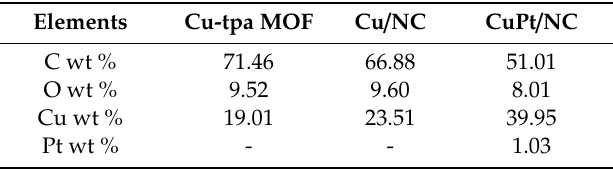
Figure 4. Transmission electron micrographs for CuPt/NC ( a ) 2 0 nm and ( b ) 10 nm . The crystalline structure of Cu-tpa MOF and CuPt/NC (pyrolyzed) was determined with powder XRD as shown in (Figure 5). XRD pattern of Cu-tpa MOF has been transformed after pyrolysis because of the removal of unstable organic linker groups and the formation of nano-porous carbon. Cu and Pt peaks are dominant peaks in the CuPt/NC. XRD graph of CuPt/NC shows sharp peak of Cu (111) at 42.7°, Cu (200) at 50.7°, CuO (−202) at 49.5°, CuO (202) at 59.2° [30], and XRD peak of Pt at (111) and (200) was observed at 2θ of 41.2° and 45.2° [31]. The positive shift of the diffraction peaks of CuPt/NC is due to incorporation of Cu atom into Pt structure. Moreover, a slight hump